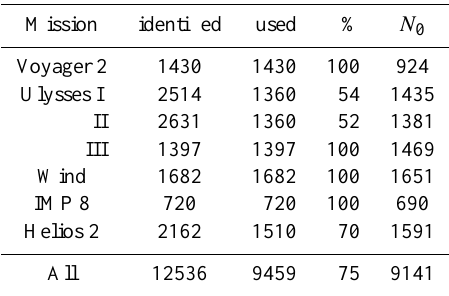
Table 2. Number of identified DDs in the intervals, the number of the ones used and the number of the usable transitions Mission